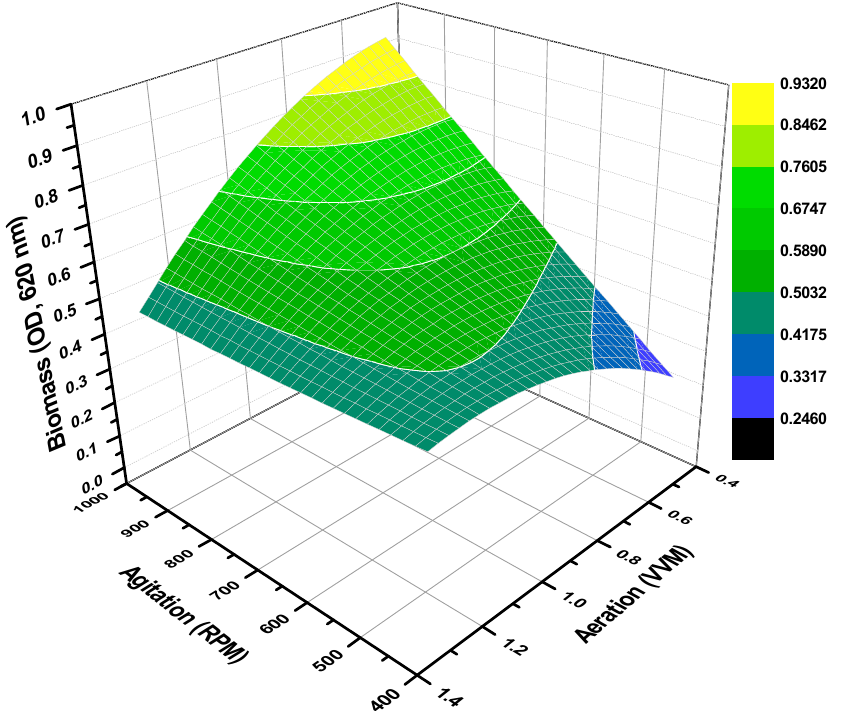
Figure 1. Theoretical biomass values calculated by the quadratic model in response surface method- ology from experimental values of biomass